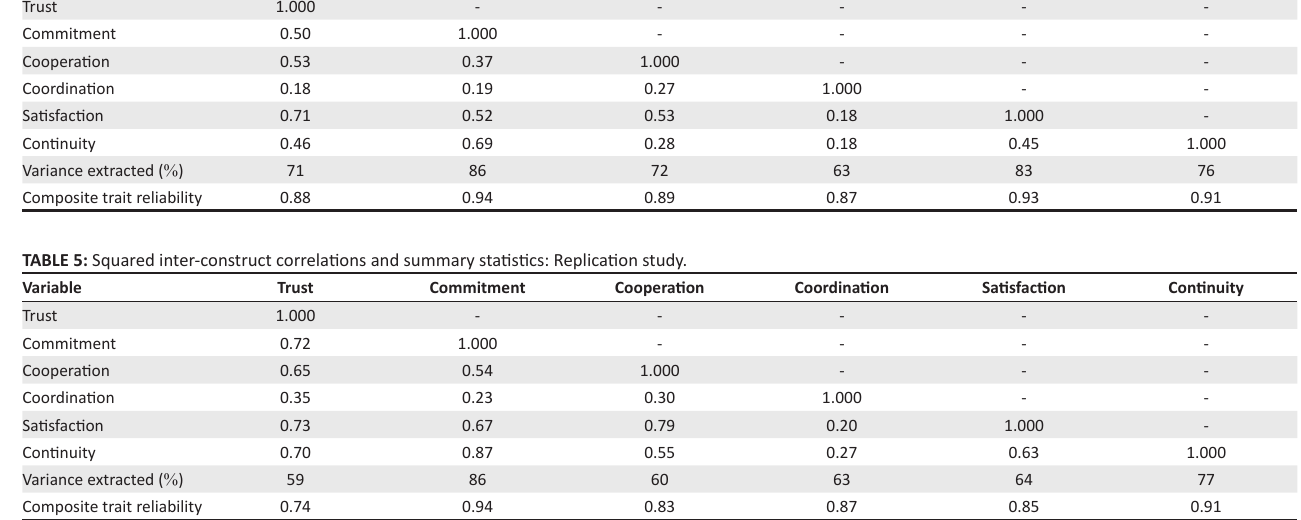
TABLE 4: Squared inter-construct correlations and summary statistics: Original study. Variable